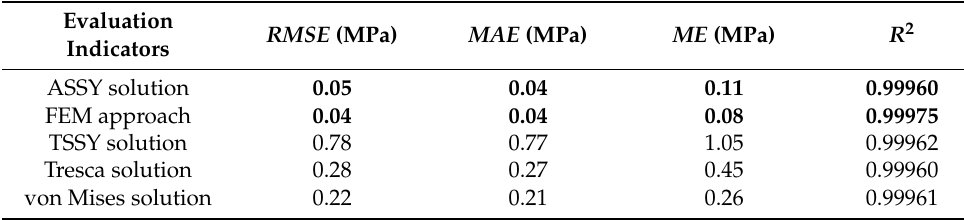
Table 4. Statistical comparison of burst pressure prediction.